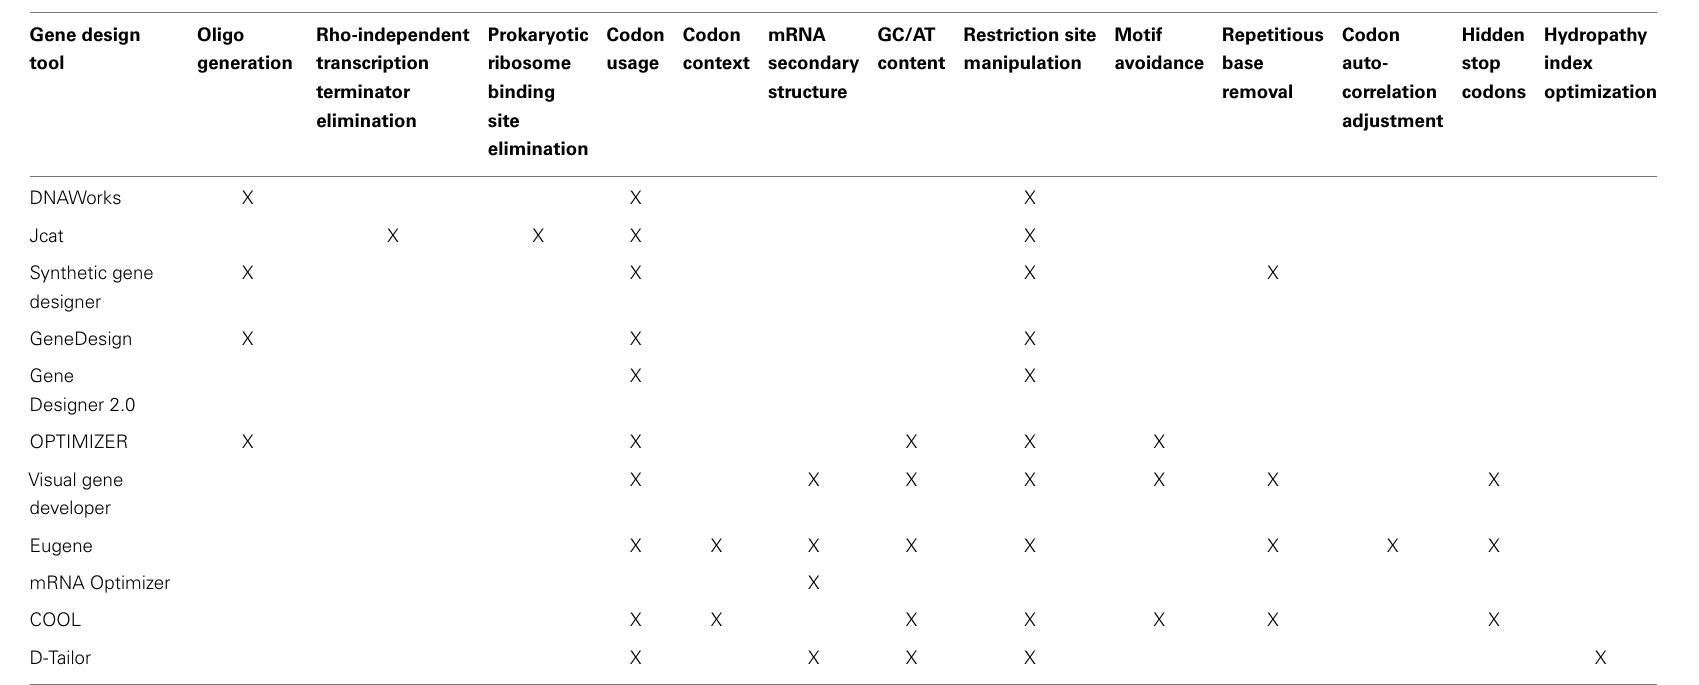
Table 2 | Overview of gene design tools’ features